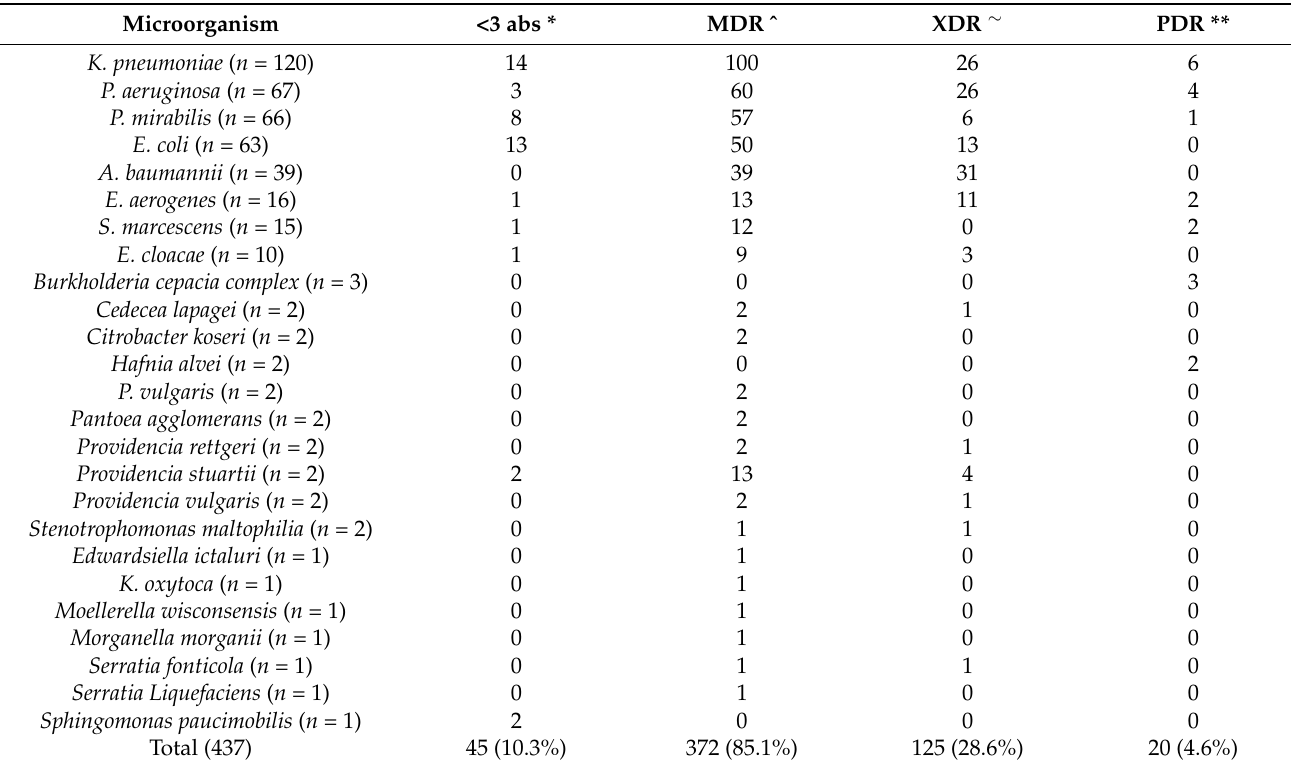
Table 3. Numbers of Gram-negative isolates showing multidrug, extensive-, and pan-drug resistance. Microorganism